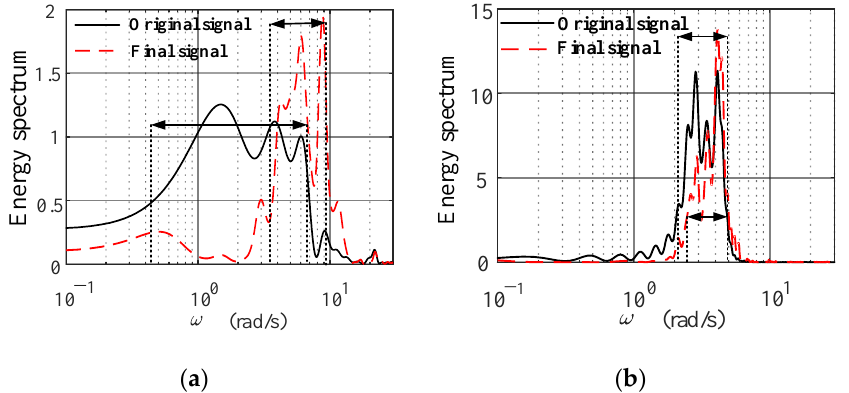
Figure 8. Energy distribution of two types of signals in the frequency domain. ( a ) The 3211-multipole square wave; ( b ) Frequency sweep.